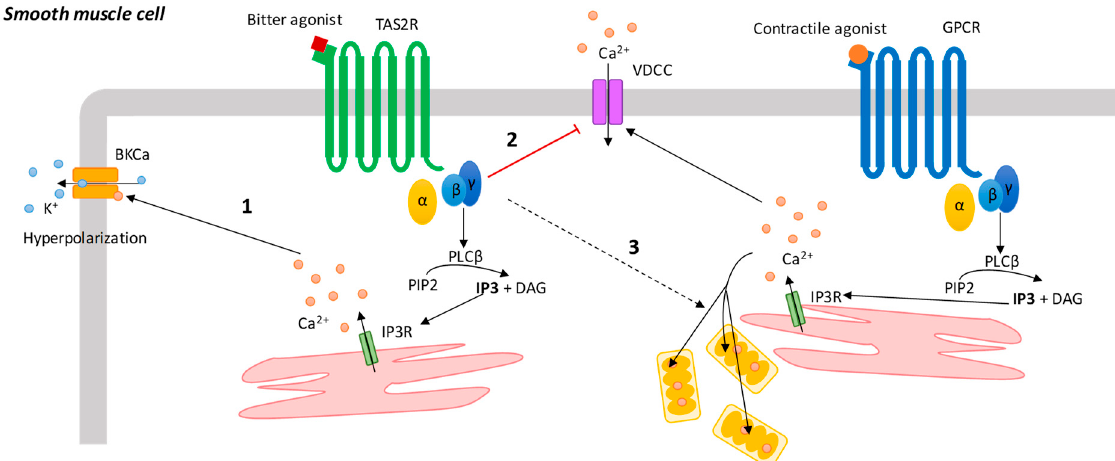
Figure 4. TAS2R signal transduction cascade in smooth muscle cells. 1. Cytosolic calcium increases open BKCa, leading to the outflow of K + and, consequently, to membrane hyperpolarization. 2. TAS2R G βγ subunit inhibits VDCC activated by a procontractile stimulus. 3. TAS2Rs promote the mitochondrial uptake of calcium released, following challenge with a procontractile stimulus.